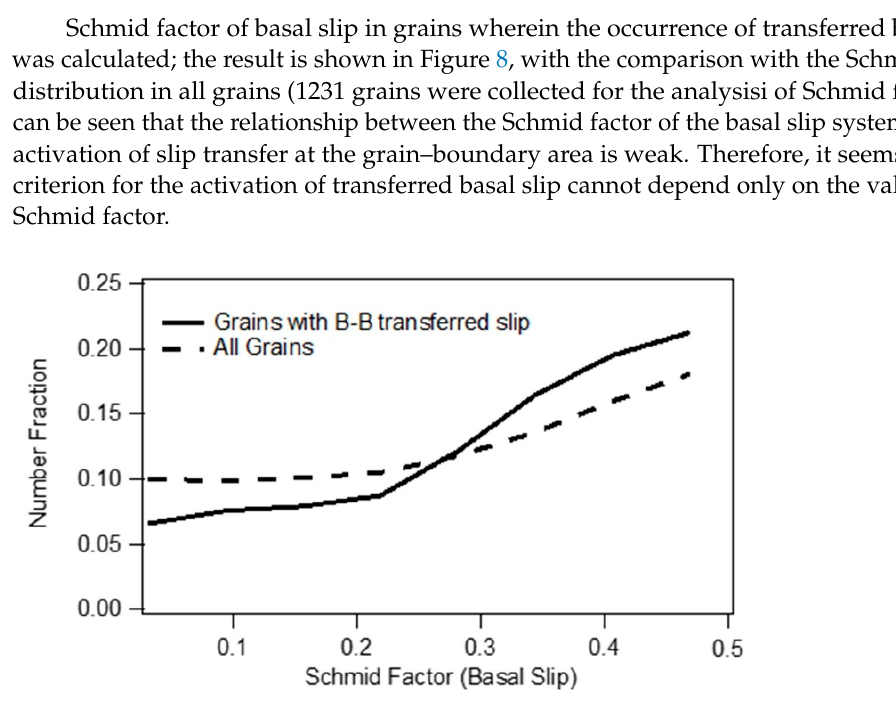
Figure 8. Relationship between Schmid factor of basal slip and number fraction of B–B transferred